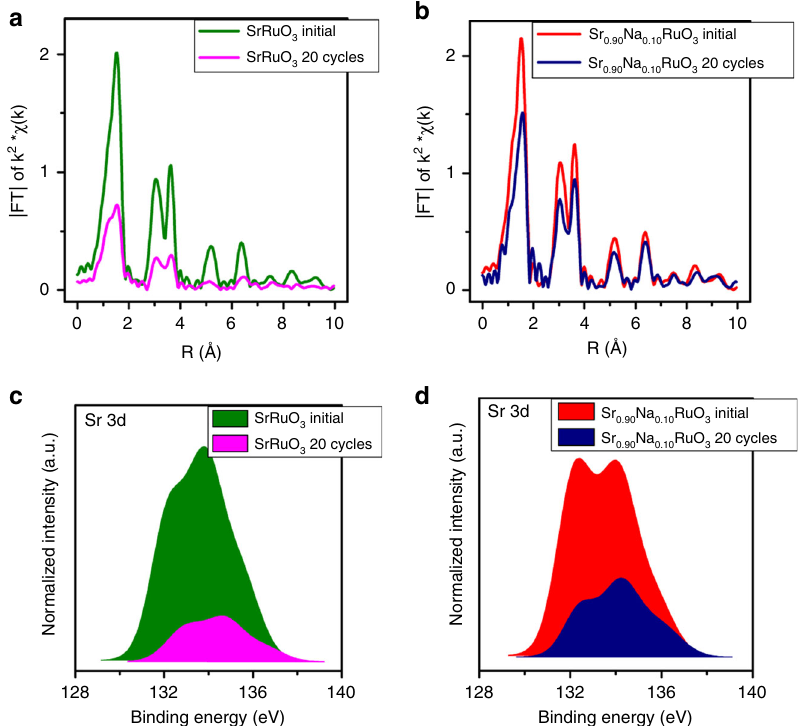
Fig. 5 XAS and XPS of fresh and cycled samples. a Fourier transform from Ru K-edge EXAFS signal before and after OER of SrRuO 3 and b of Sr 0.90 Na 0.10 RuO 3 . c Sr-3d core-level region before and after OER of SrRuO 3 and d of Sr 0.90 Na 0.10 RuO 3 . The intensity of the Sr peaks in the used samples is normalized to the intensity of Sr in the fresh